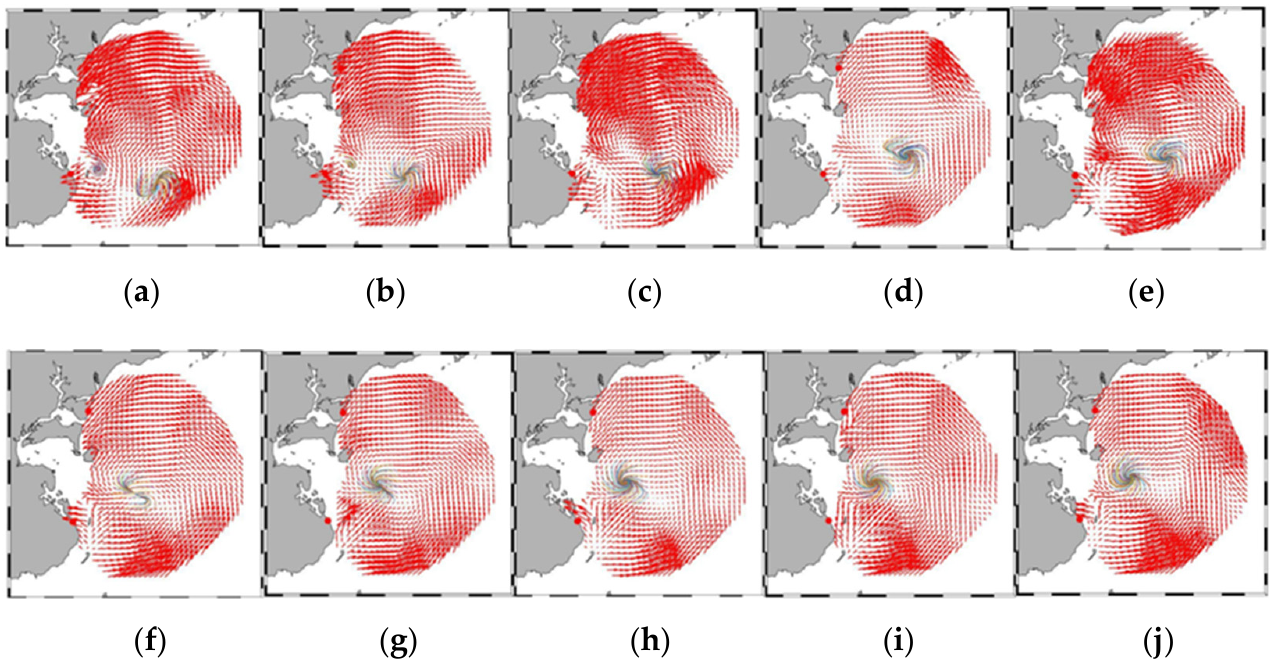
Figure 12. The eddy movement from 11:20 to 14:20, August 30, 2017. ( a ) 11:20, ( b ) 11:40, ( c ) 12:00, ( d ) 12:20, ( e ) 12:40, ( f